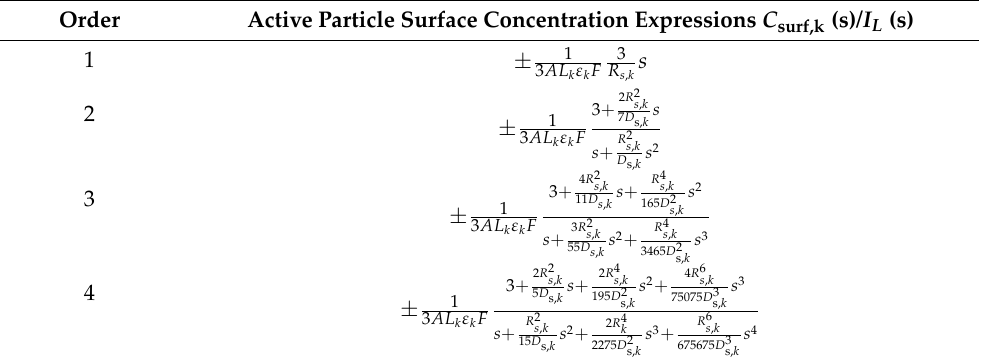
Table 1. The results of Pad é approximation including different orders for C surf .